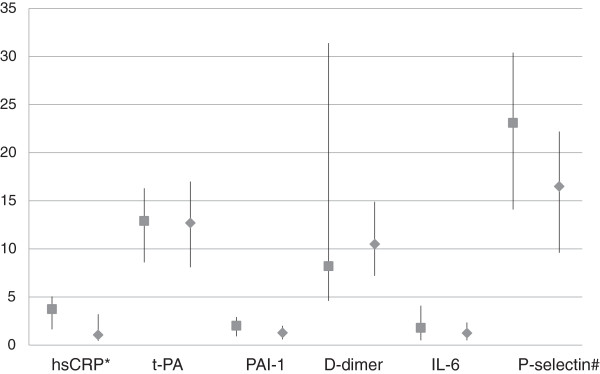
Plasma levels of biomarkers on late samples in cases and matched controls. Values indicate medians (full squares in cases and full diamonds in controls), bars indicate interquartile ranges. hsCRP = high-sensitivity C-reactive protein in mg/L; t-PA = tissue plasminogen activator in ng/mL; D-dimer in μg/100 mL; PAI-1 = plasminogen activator inhibitor-1 in μg/10 mL; IL-6 = interleukin-6 in pg/mL; P-selectin = platelet selectin in μg/100 mL. *p=0.002; #p=0.005 from fitting a conditional logistic regression (biomarkers in log scale) comparing cases and controls.